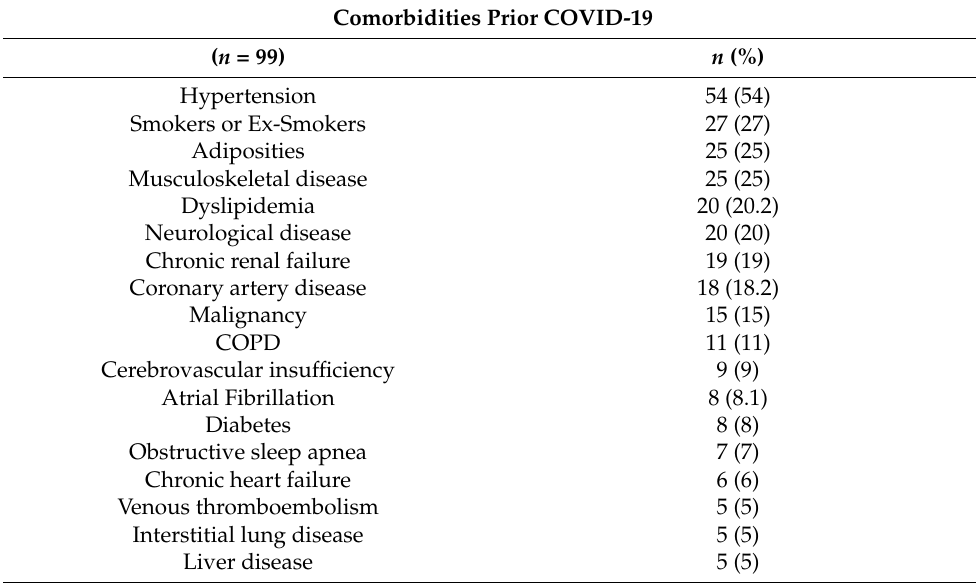
Table 3. Comorbidities of post-COVID-19 patients prior to COVID-19